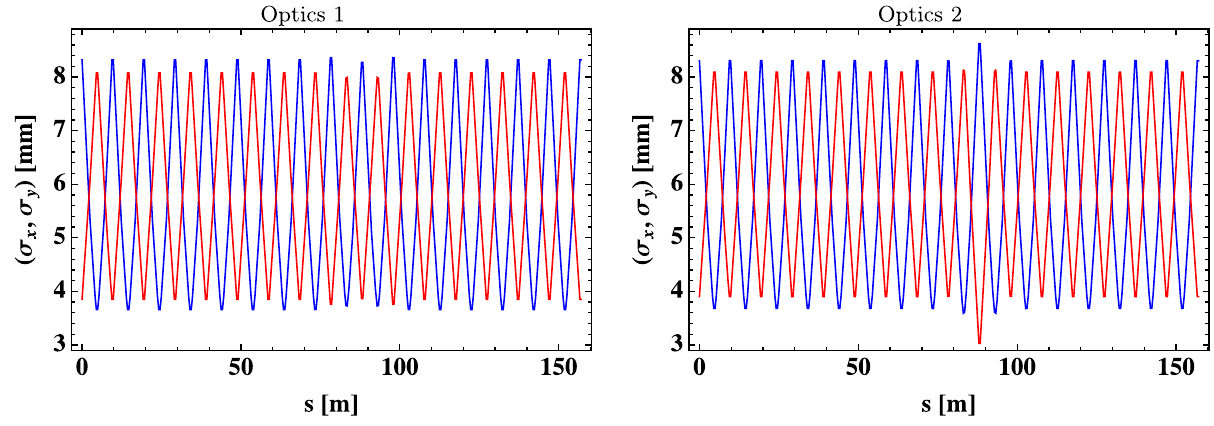
FIG. 14. One rms beam envelope of two different optics of the 16-cell FODO lattices with onefold symmetry and a working point of Q =Q ¼ 4 . 28 = 3 . 55 : Optics 1 (left) with a small variation of the regularity of the beam size and Optics 2 (right) with a large variation. x y The beam envelope has been calculated using the design transverse normalized rms emittance of 2 . 5 μ m and the rms momentum spread corresponding to the design longitudinal emittance of 2.8 eVs.